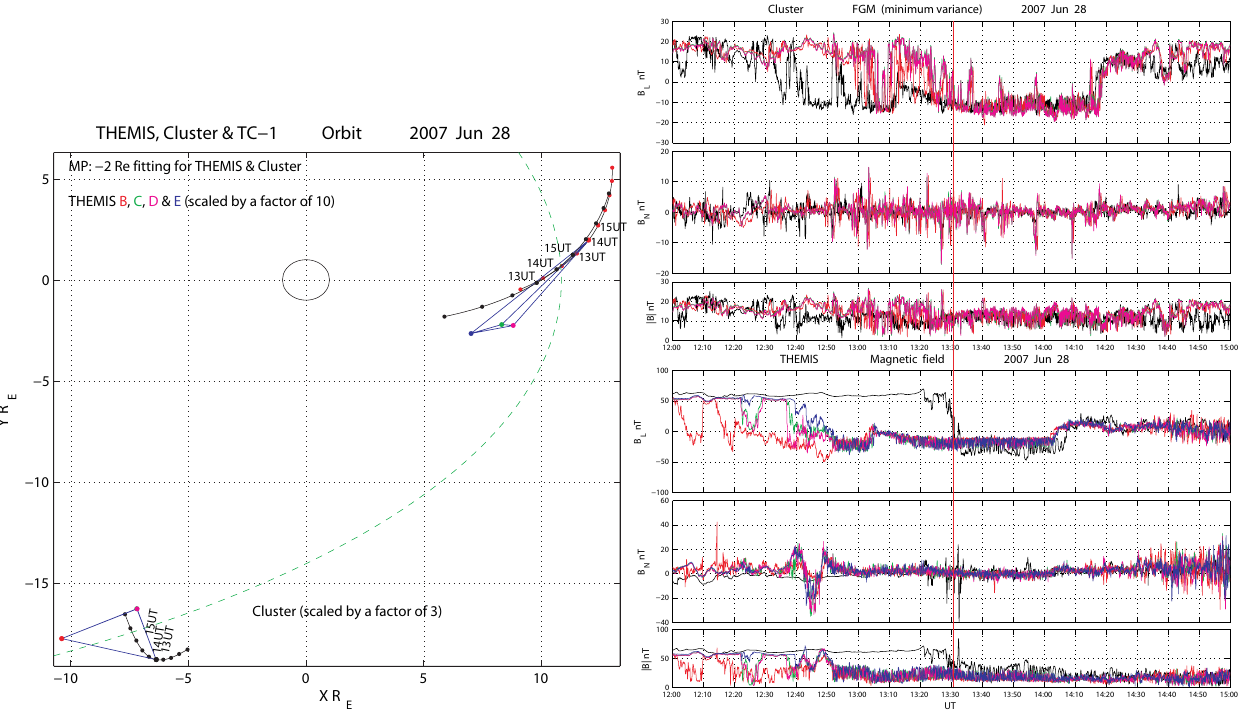
Fig. 5. A conjunction between the four Cluster and five THEMIS spacecraft, during an initially northward IMF, in a similar format to Fig. 1.